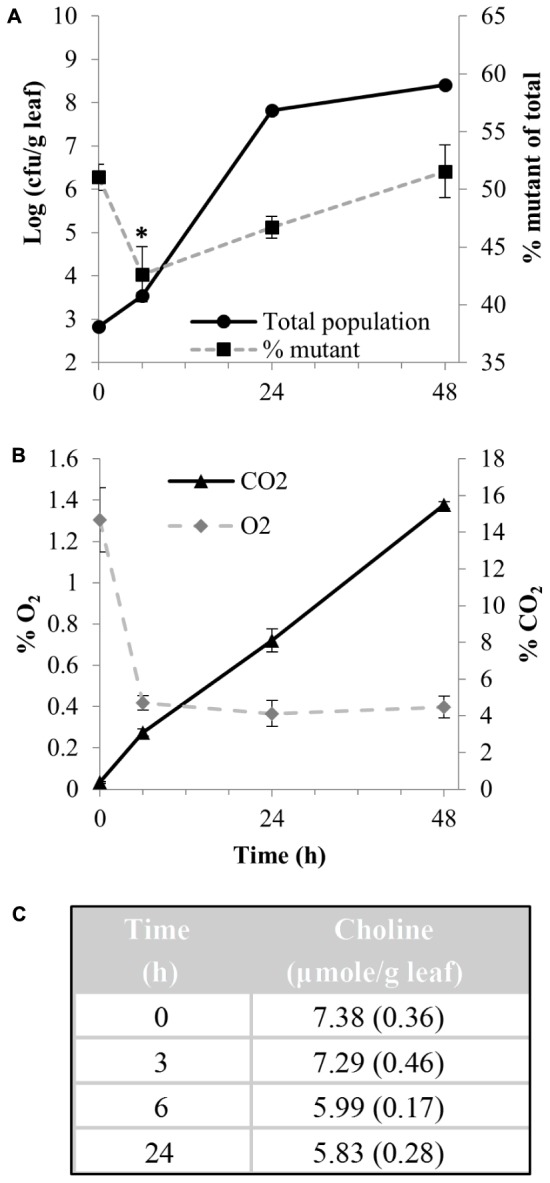
Competitive fitness of EcO157 WT and betTIBA-otsBA mutant in MAP cut lettuce, and chemical environment determinations. (A) Total EcO157 population size per g cut lettuce () and percentage of the betTIBA-otsBA mutant in the total EcO157 population () after their co-inoculation onto MAP cut lettuce. (B) Atmospheric O2 and CO2 content in the MAP bags from which the EcO157 strains were recovered. (C) Choline content in washes of MAP cut lettuce over time as measured via enzyme assay. All values represent mean measurements from three replicate bags. Standard error of the mean given as error bars or in parentheses. ∗ indicates a significant difference in the % of mutant over total EcO157 cells at 6 h compared with the initial % at the time of inoculation (0 h), based on Student’s t-test on transformed % data (P < 0.05).